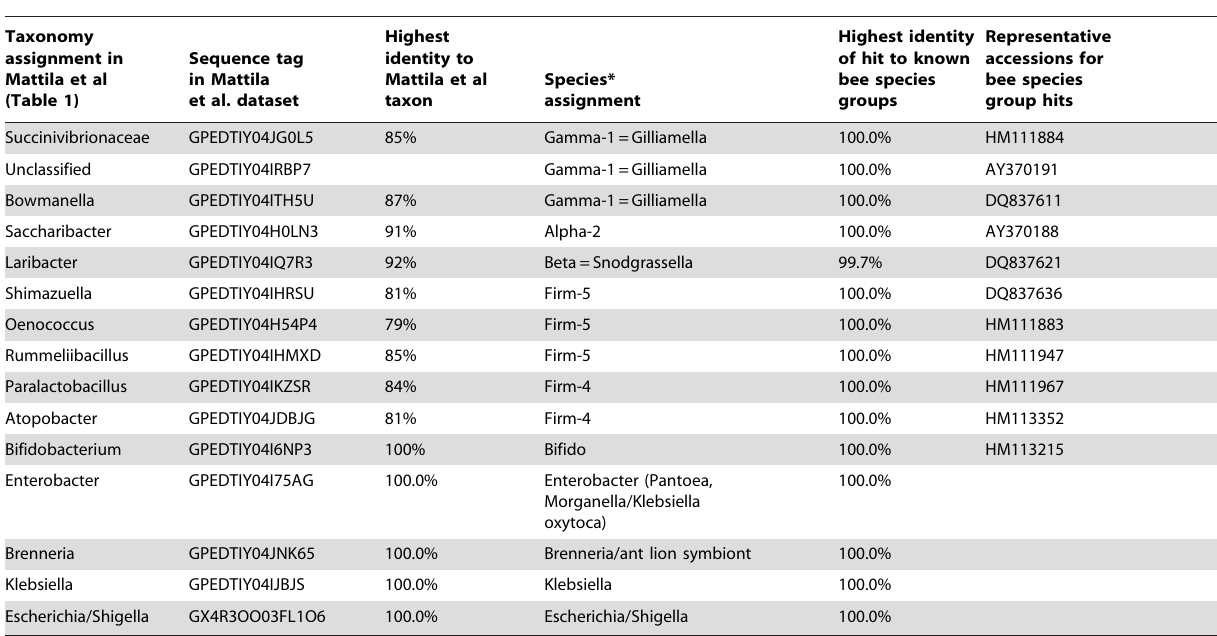
Table 3. Many of the most active taxa from the Mattila et al. [15] study are identical to known bee species groups.